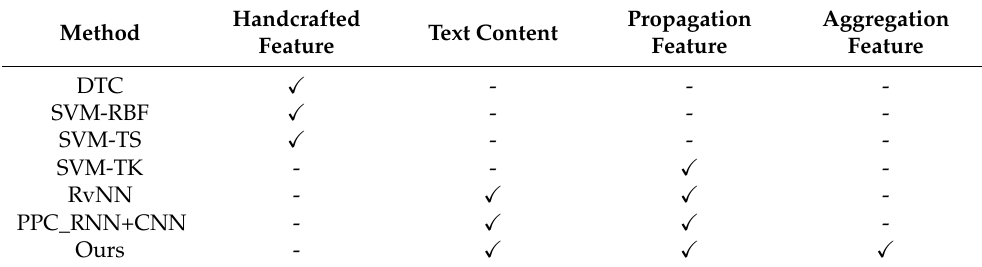
Table 2. Comparison of the features of all